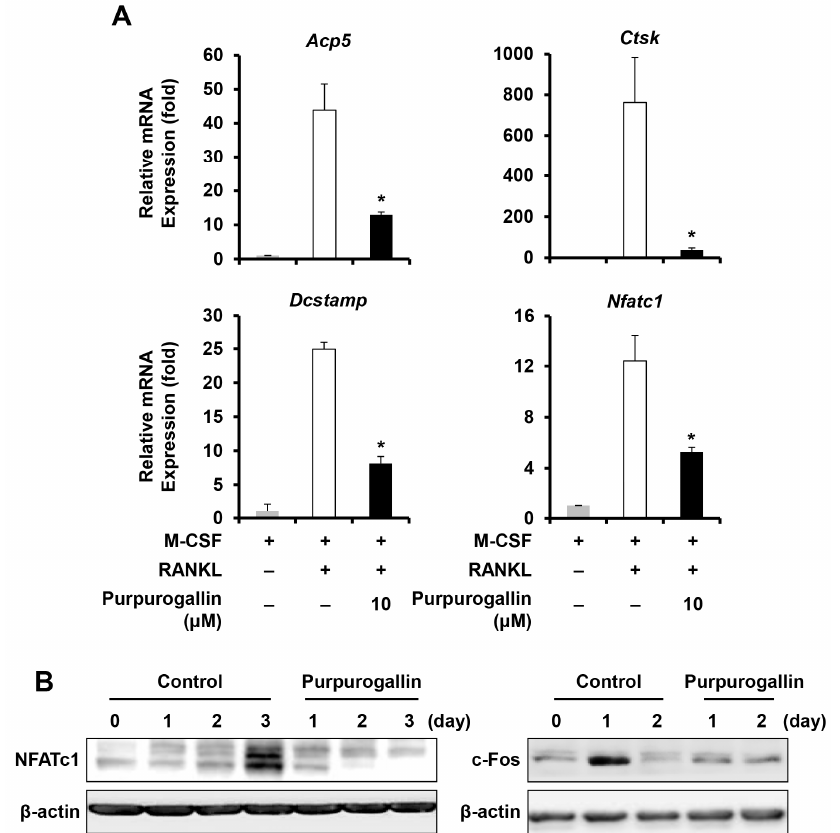
Figure 2. Purpurogallin treatment ameliorates the expression of osteoclast-specific markers during osteoclastogenesis. ( A ) BMMs were cultured in an osteoclastogenic medium with vehicle or purpurogallin (10 μ M) for 4 days. The mRNA expression of TRAP ( Acp5 ), cathepsin K ( Ctsk ), DC-STAMP ( Dcstamp ), and NFATc1 ( Nfatc1 ) genes was evaluated using real-time PCR. * p < 0.05; ( B ) BMMs were cultured in an osteoclastogenic medium in the absence or presence of 10 μ M purpurogallin for the indicated time period. The protein expression of NFATc1 and c-Fos was determined using western blotting.